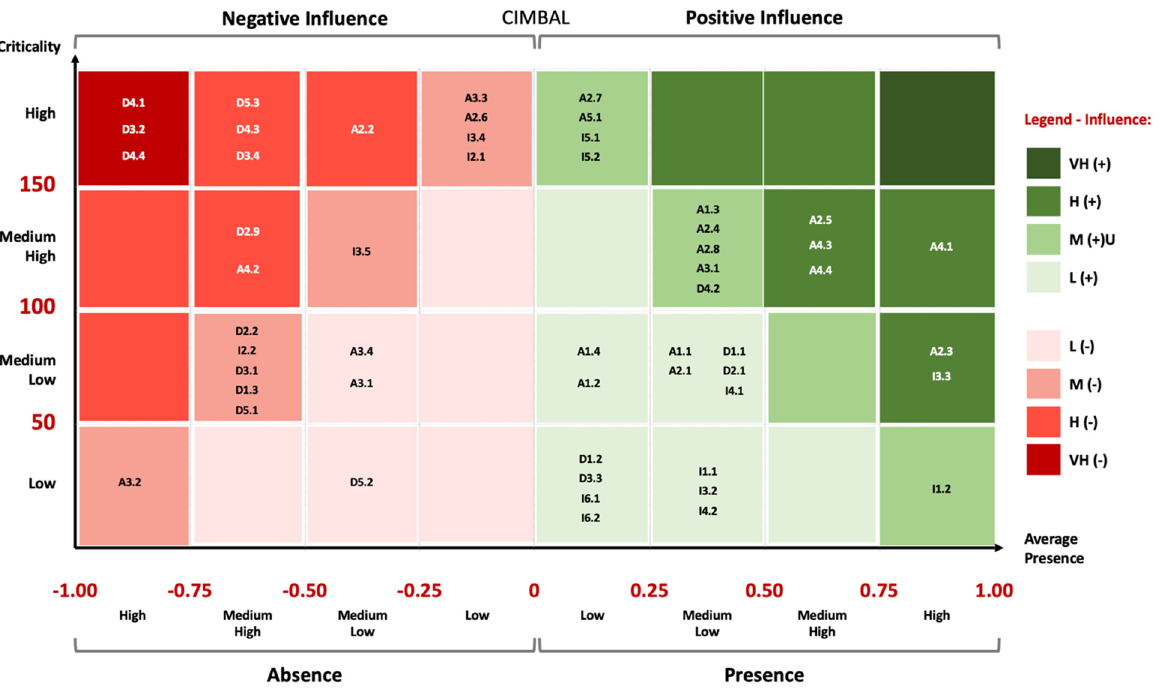
Figure 10. Matrix of Influence With 53 Categories (CIMBAL) . Source: the authors.